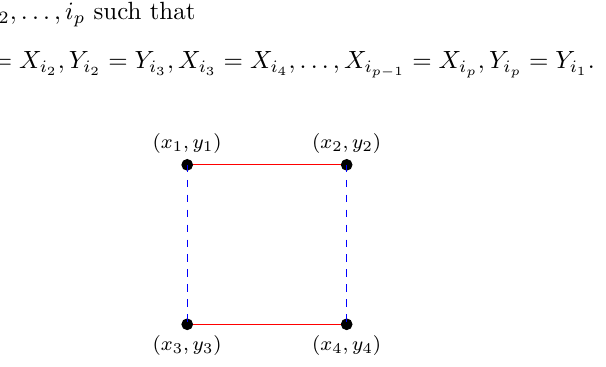
Figure 2.1: Alternating Cycle of length 4. Continuous line indicates first coordinate matches. Dotted line indicates second coordinates